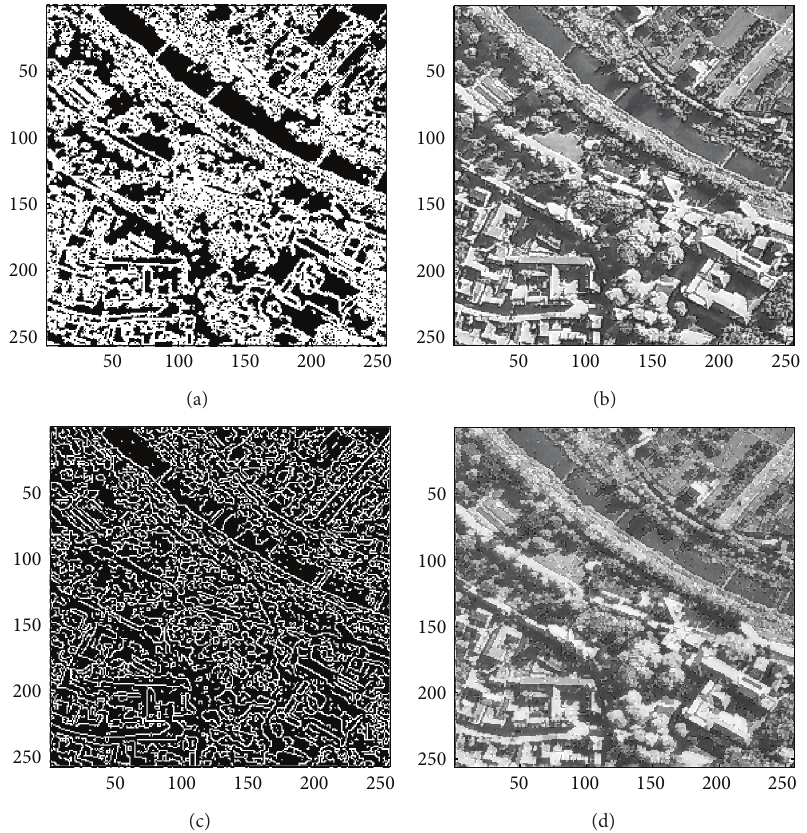
= 12 in the image “Aerial.” (b) Result by HVD with scaling factor 𝑠 = 1.0 . (c) Edges detected Figure 8: (a) Edges detected by HVD with 𝜃 eth by Canny operator in the image “Aerial.” (d) Result by Canny operator with scaling factor 𝑠 = 1.0